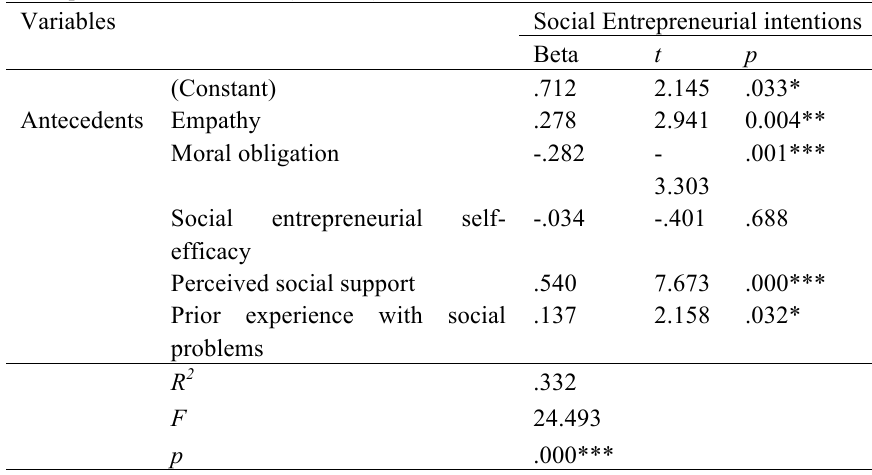
Multiple regression analysis of the effects of the antecedents on social entrepreneurial intentions (n = 252)